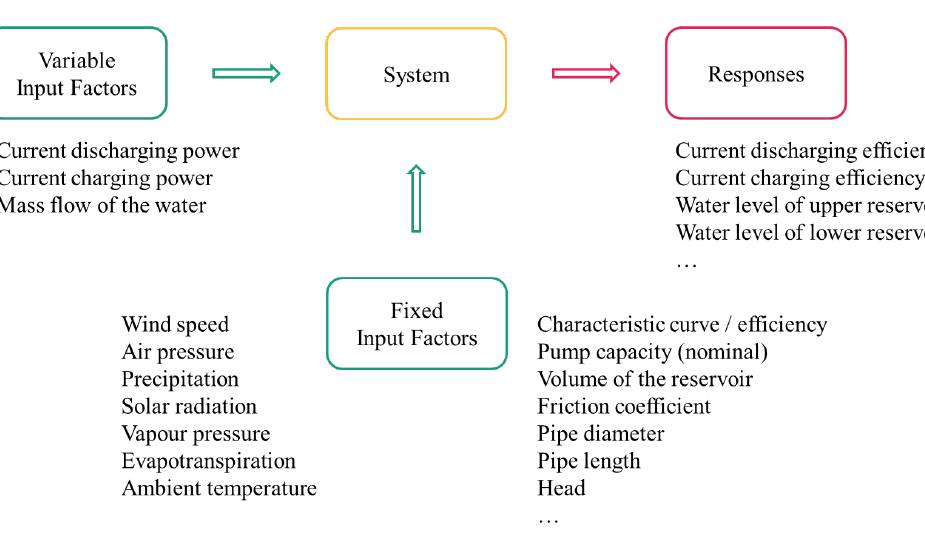
Figure 3. Parameter diagram with a selection of factors and responses. Own representation based on